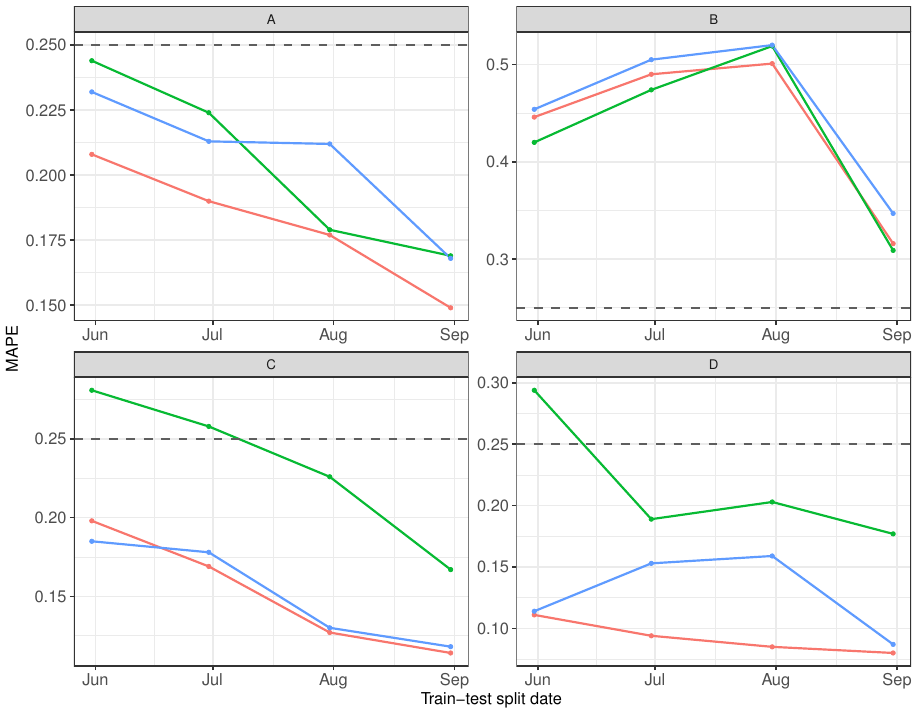
Figure 6. Value of mean absolute percentage error (MAPE) for locations ( A – D ) and each split date for train-test datasets. The dashed line indicates the maximum error threshold—25%.